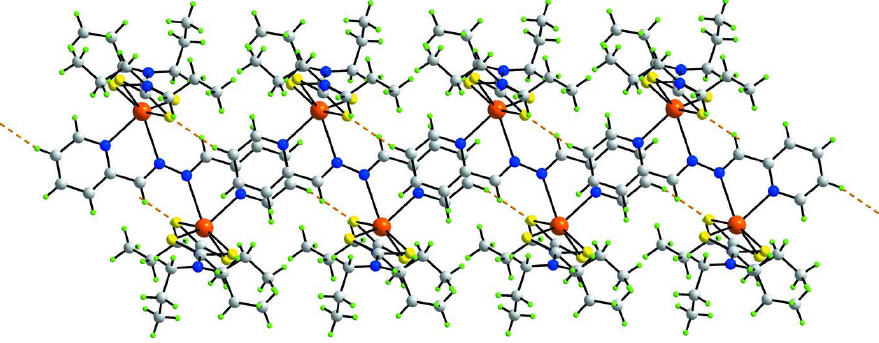
View of a supramolecular chain in (I) highlighting the overlap of the aromatic rings to allow the formation of the π – π interactions. The C—H···S3 interactions are shown as orange dashed lines. Colour code: Cd (orange), S (yellow), O (red), N (blue), C (grey) & H